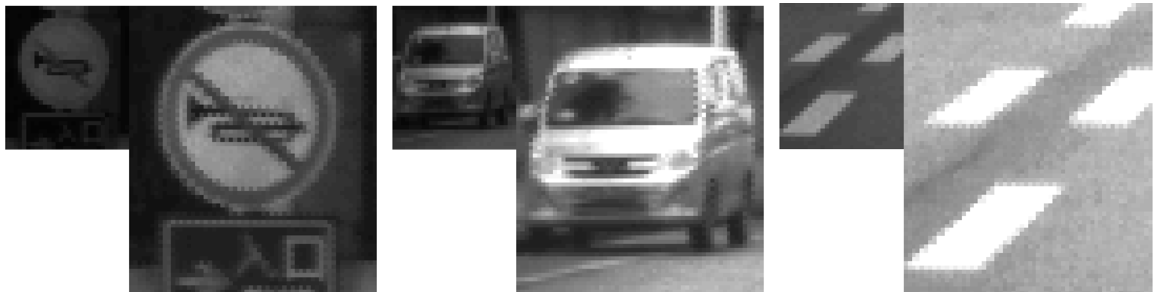
Figure 4. Three sample parts of source RCCC image decomposed into two images with R and CCCC components (the second image is created with the CCC components while the missing values are interpolated).